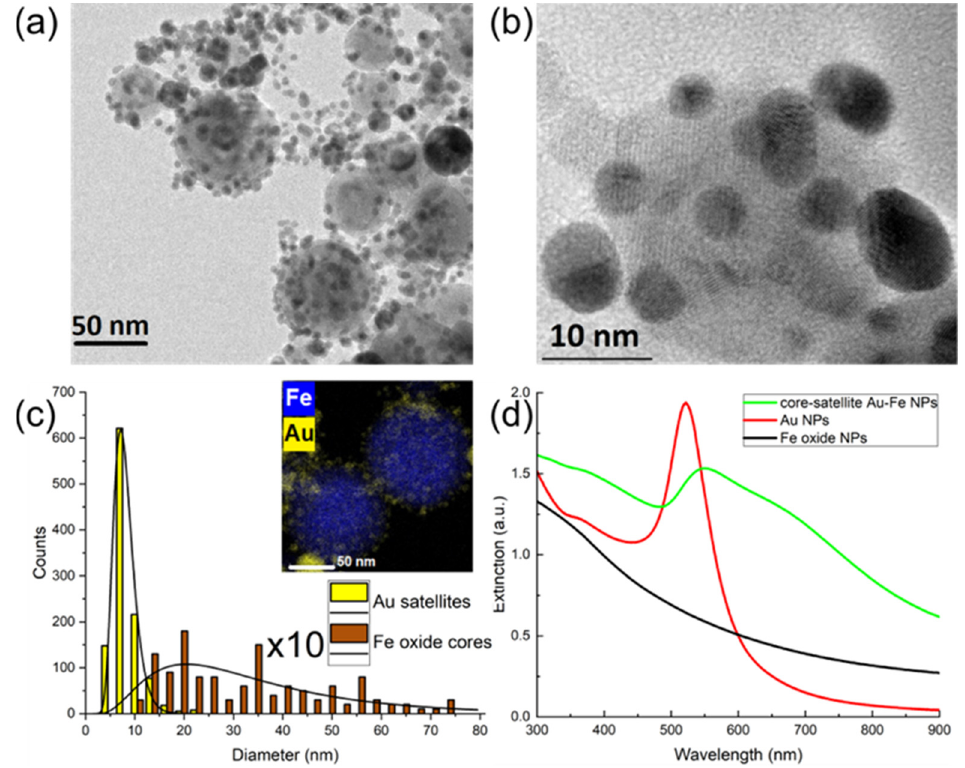
Figure 2. Characterization of core-satellite Au-Fe NPs. ( a ) TEM image of the NPs. ( b ) HR-TEM image of the NPs. ( c ) Size distribution of Au satellites (yellow) and Fe oxide cores (brown) (note that amount of cores is multiplied by 10). The inset demonstrates elemental mapping (Fe—blue, Au—yellow) of the NPs measured by EDX technique. ( d ) Optical extinction spectra of Fe oxide NPs (black curve), Au NPs (red curve) and core-satellite Au-Fe NPs (green curve).